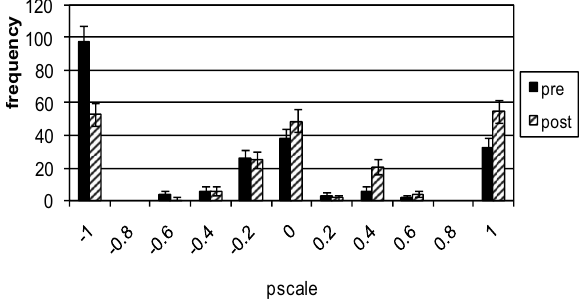
FIG. 2. Distribution of students who have a given problem- solving preference, pscale, where pscale= (cid:1) expansive −limiting (cid:2) / (cid:1) expansive+limiting (cid:2) . The reflections written at the start of the course (cid:1) “pre” (cid:2) are shown in solid black and the reflections written at the end of the course (cid:1) “post” (cid:2) are shown as a striped histogram.